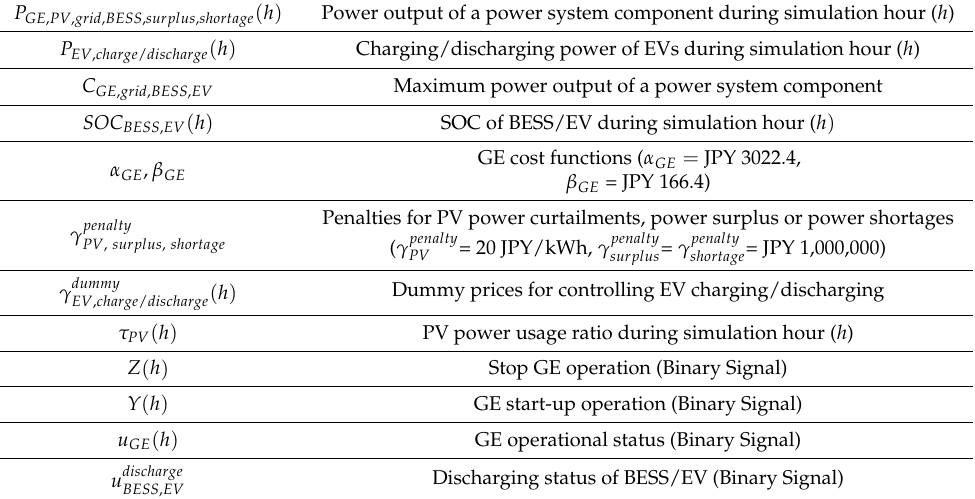
u discharge BESS , EV